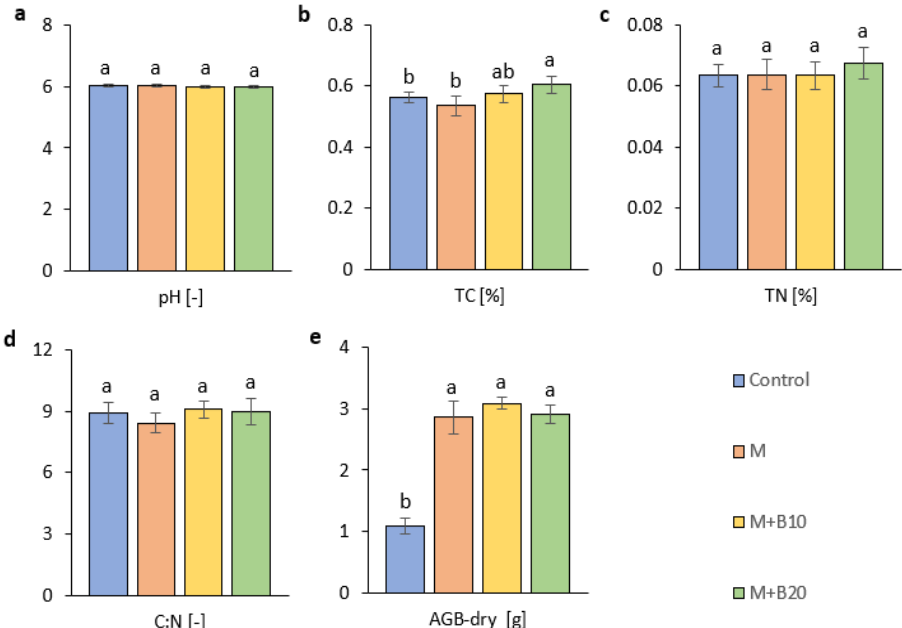
Figure 1. The effects of different amendments on: ( a ) soil pH; ( b ) total carbon; ( c ) total nitrogen; ( d ) carbon: nitrogen ratio; and ( e ) aboveground dry biomass of lettuce in a pot experiment. Different lowercase letters represent statistical difference at p = 0.05, ( n = 3).